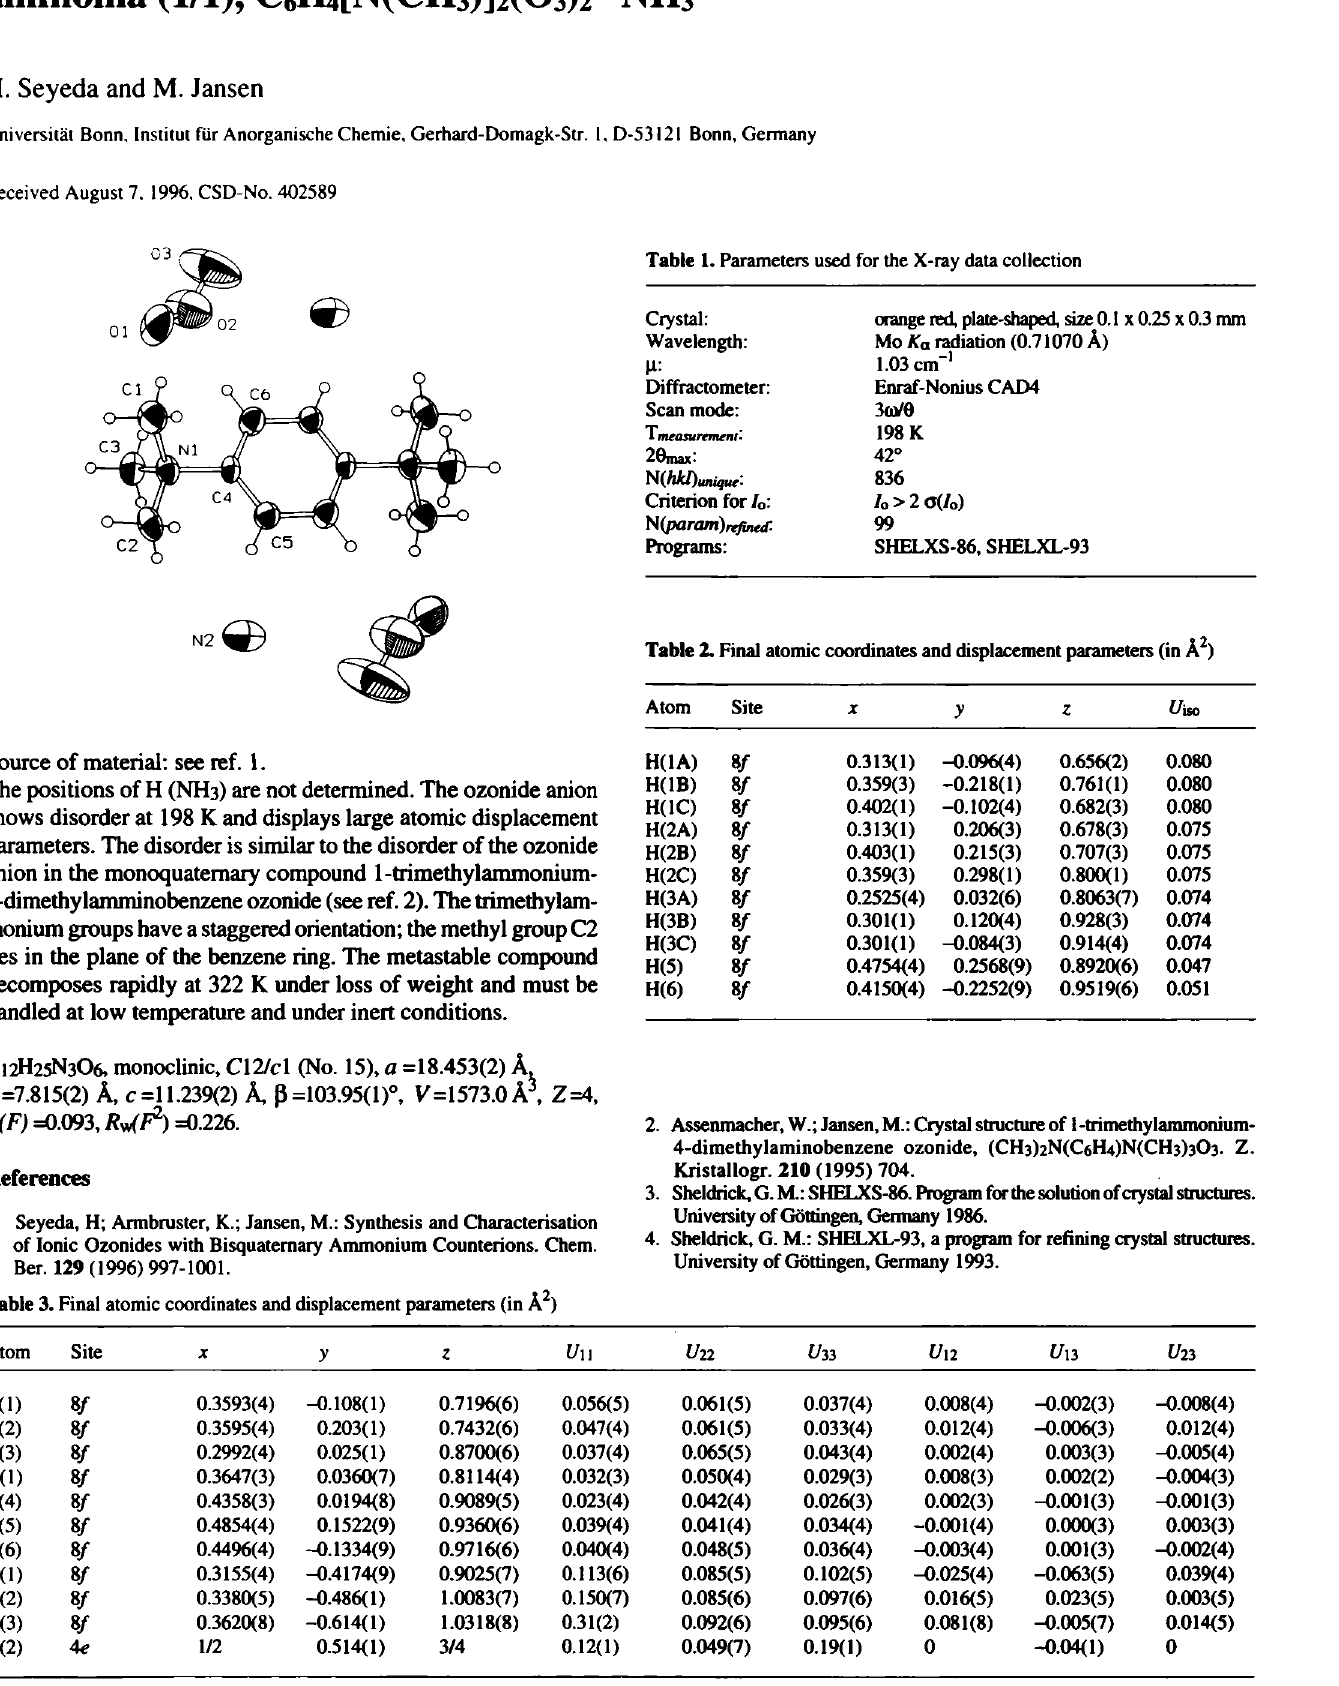
Table 1. Parameters used for the X-ray data collection